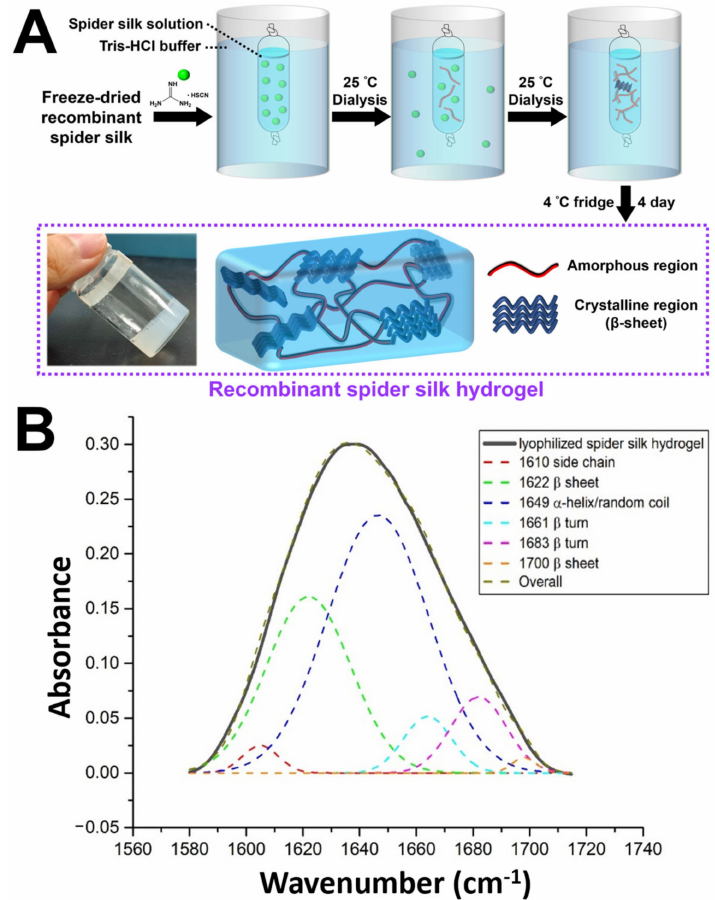
Figure 2. Fabrication and characterization of the recombinant spider silk hydrogel. ( A ) Schematic illustration of the fabrication procedure of the recombinant spider silk hydrogel. The inset shows the image of the fabricated recombinant spider silk hydrogel. ( B ) The attenuated total reflectance-Fourier transform infrared (ATR-FTIR) deconvolution analysis of lyophilized spider silk